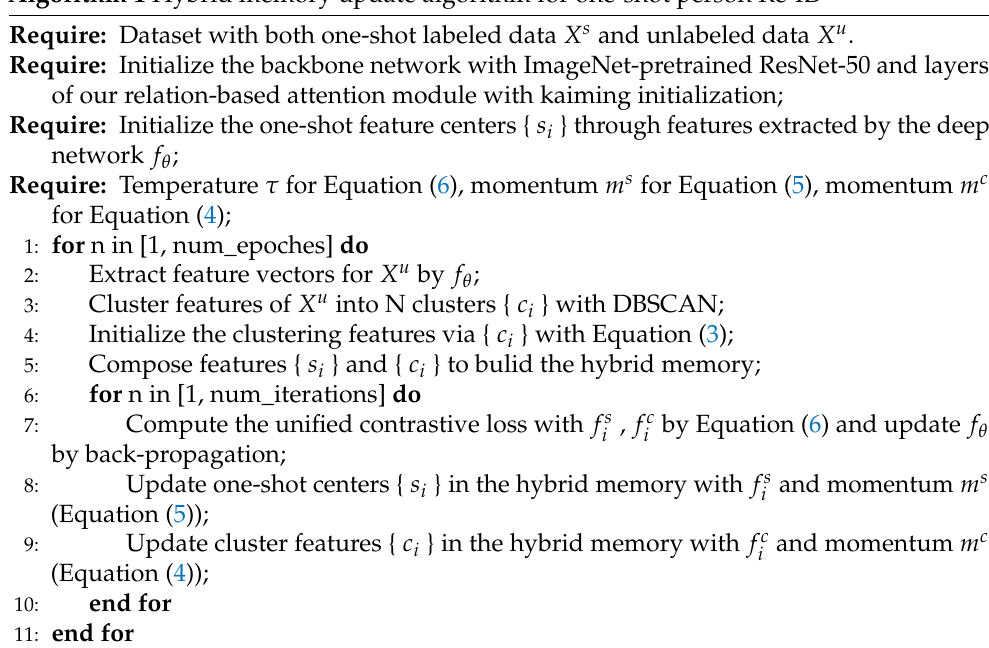
Algorithm 1 Hybrid memory update algorithm for one-shot person